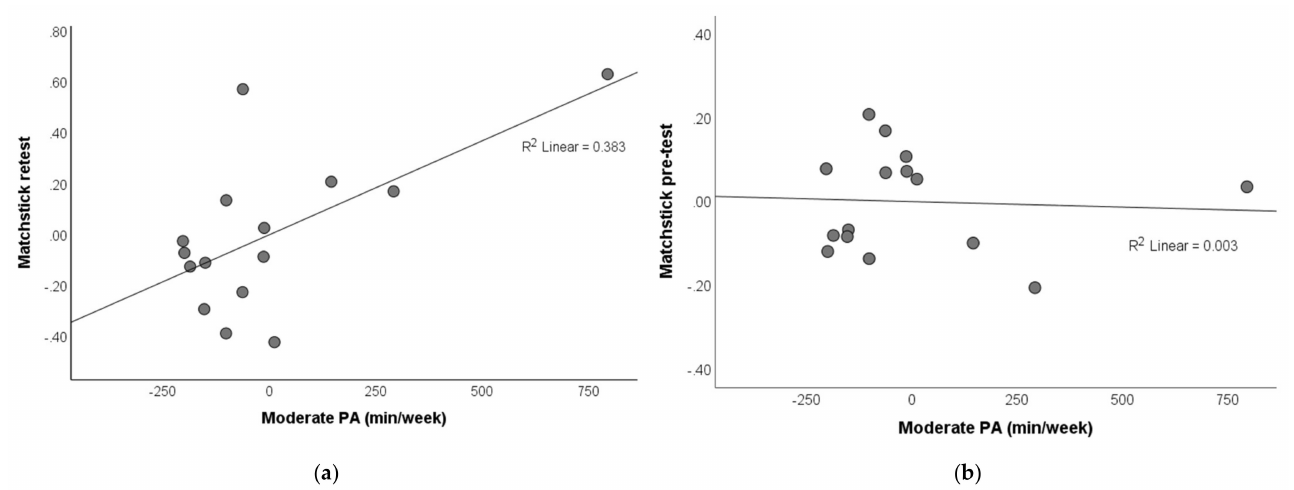
Figure 4. Partial regression plot of the association between moderate-intensity PA and convergent thinking in control group. ( a ) Matchstick retest after the intervention. ( b ) Matchstick pre-test at